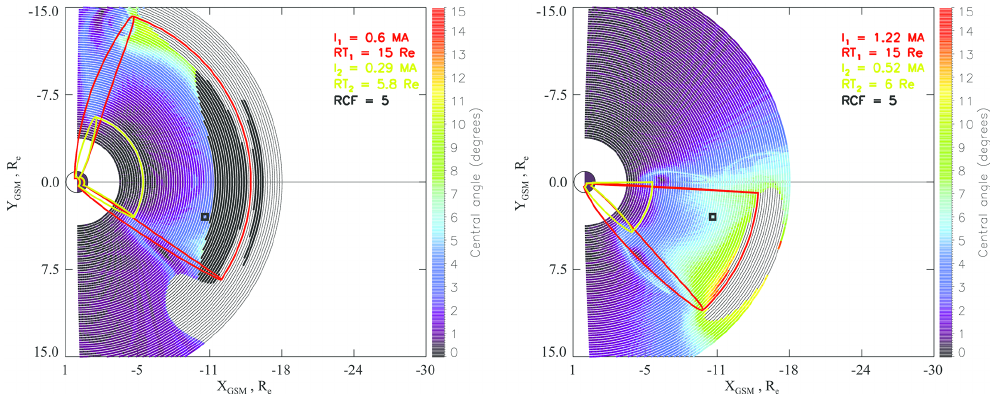
Figure 7. Same as in Fig. 2, but predicted for the peak epochs of two SCW activations, shown in Fig. 6. The black square points indicate dummy spacecraft location relative to the SCW (in the neutral sheet, X =− 11Re, Y = 3Re and Z =−